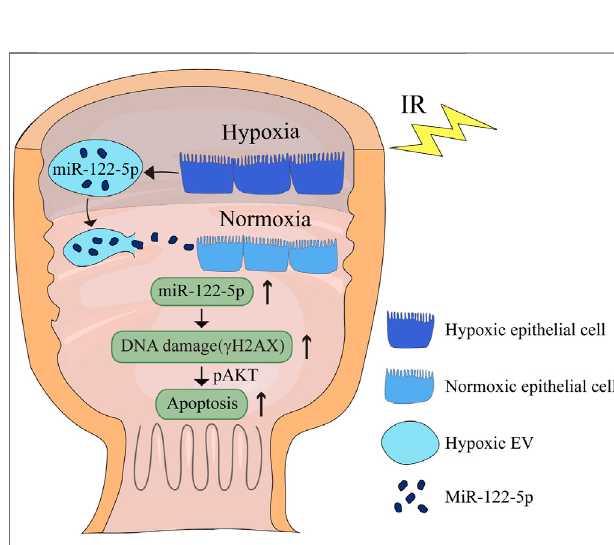
FIGURE 6| Schematic diagram ofthe effect of hypoxic EV-derived miR- 122-5p on normoxic rectum. IR, ionizing radiation.